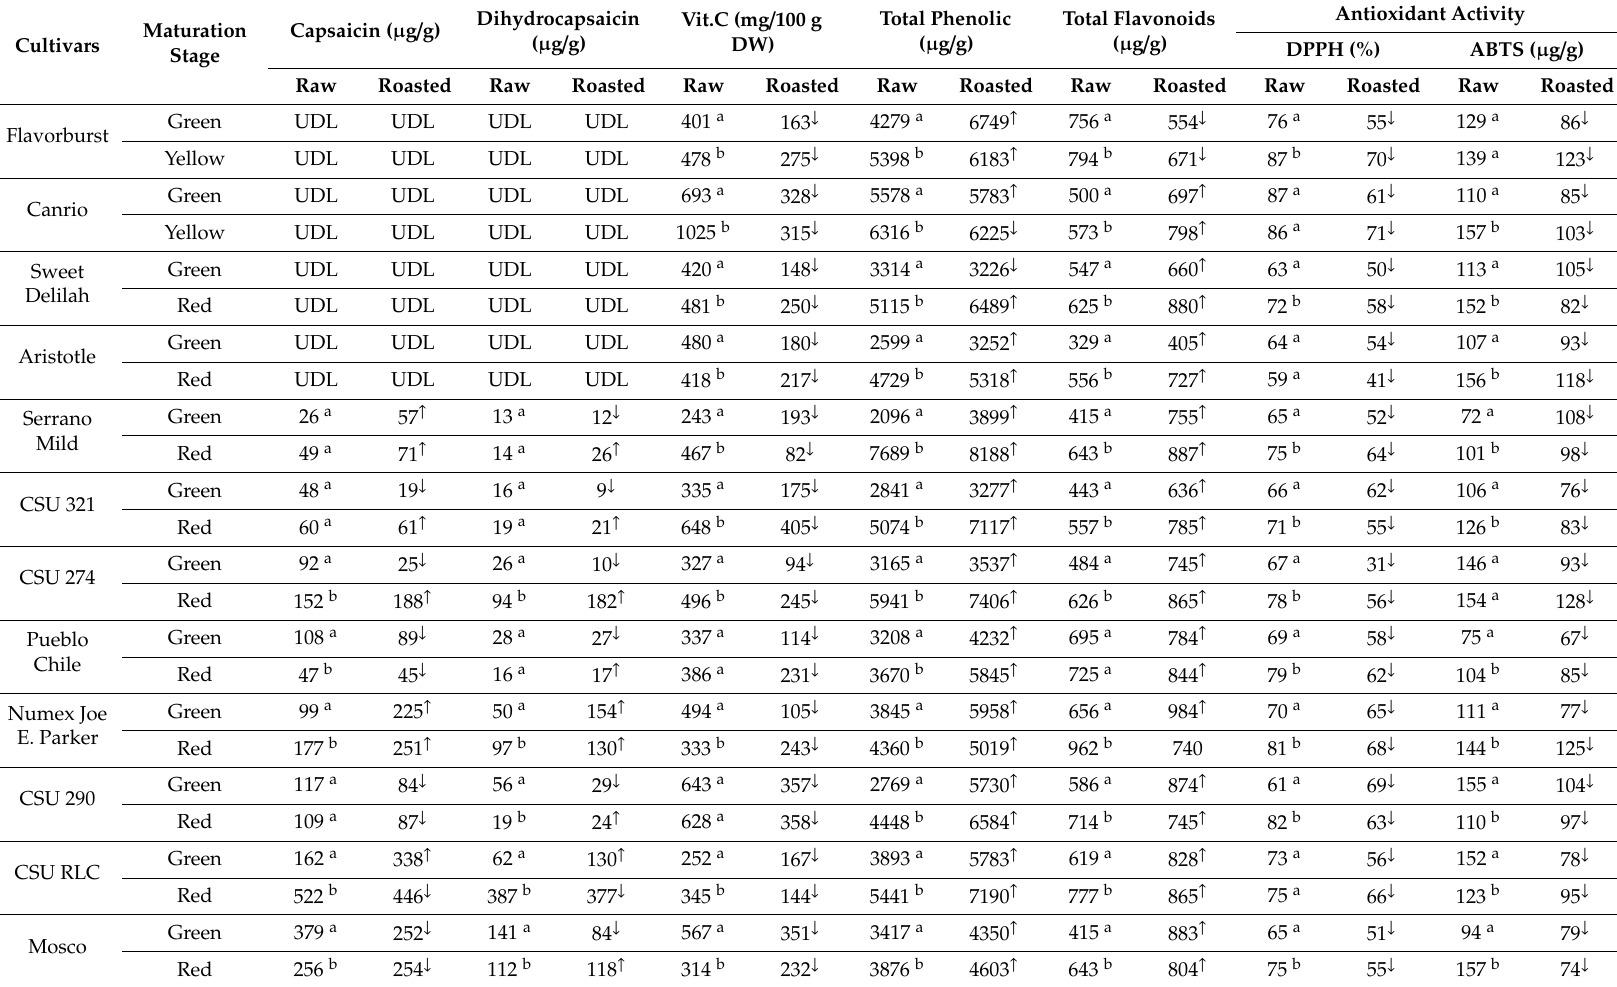
Table 1. Change in content of capsaicinoid compounds in pepper pods as a function of ripening stage and cooking. E ff ect of roasting on the nutrient contents in C. annuum and C. Chinense viz.